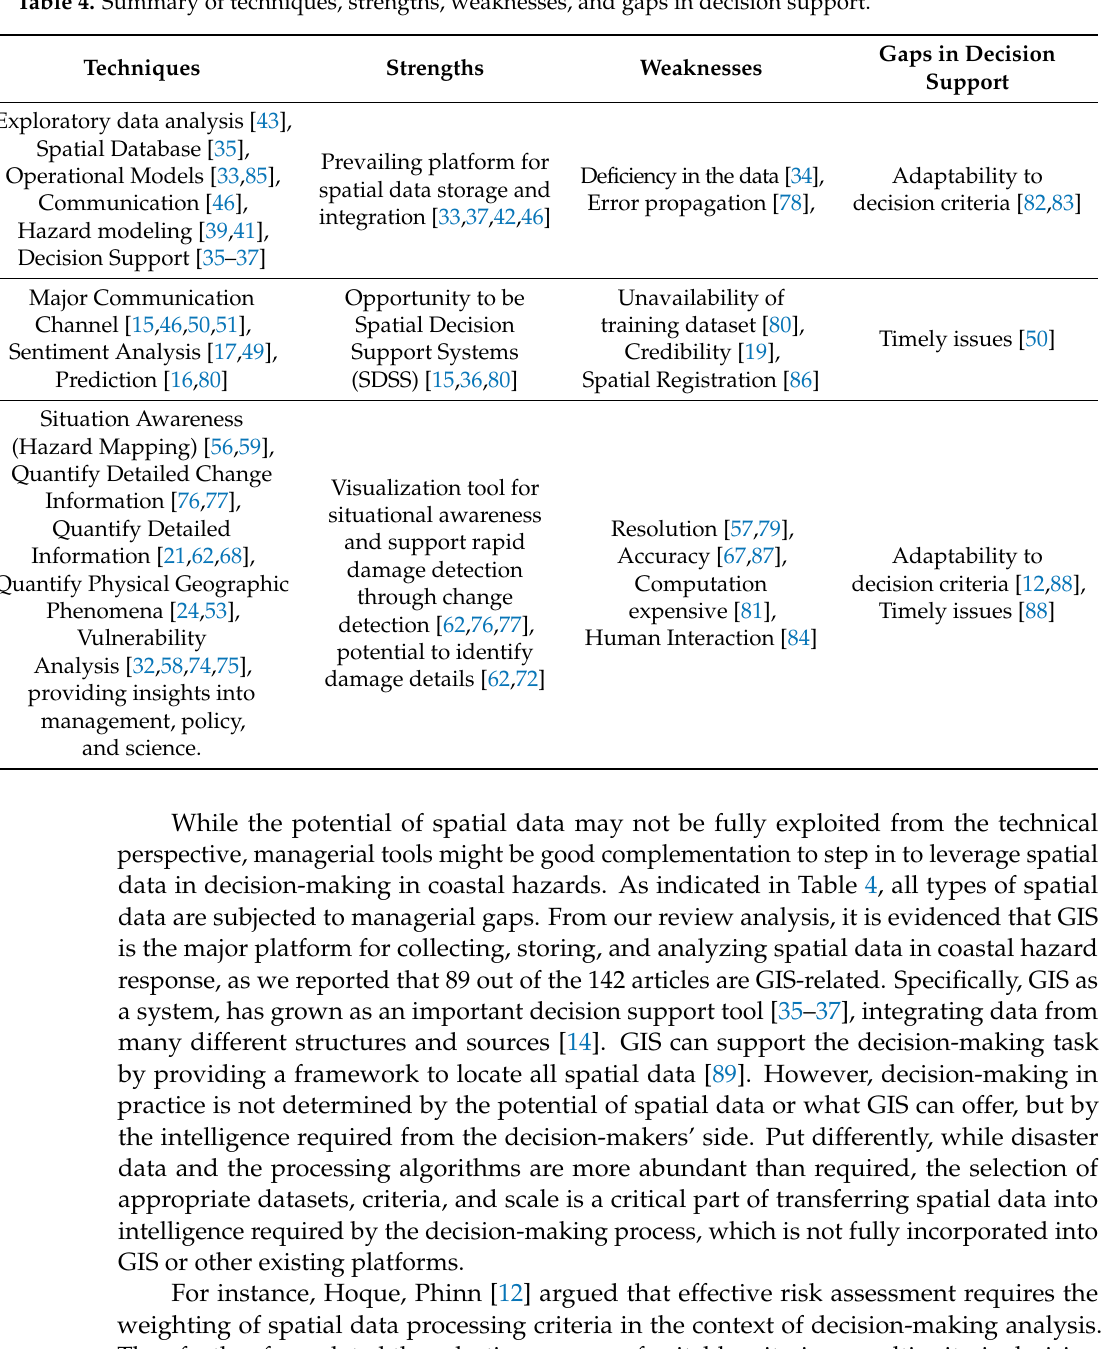
Table 4. Summary of techniques, strengths, weaknesses, and gaps in decision